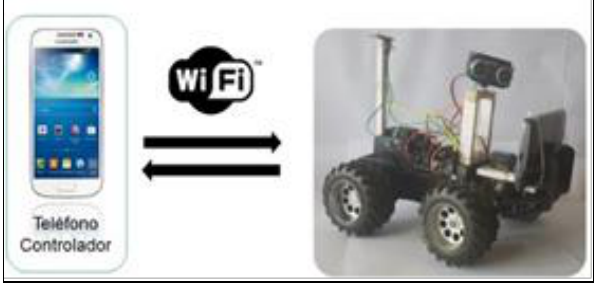
Figura 4: Concepción del sistema. Fuente: Los autores, (2018).